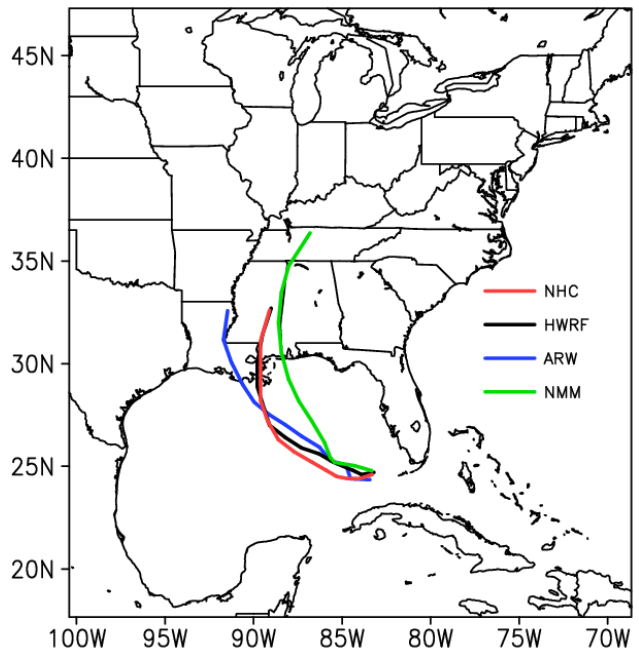
Figure 9. Predicted track positions of Hurricane Katrina from ARW, NMM and HWRF models along with observed track positions from US National Hurricane Center.